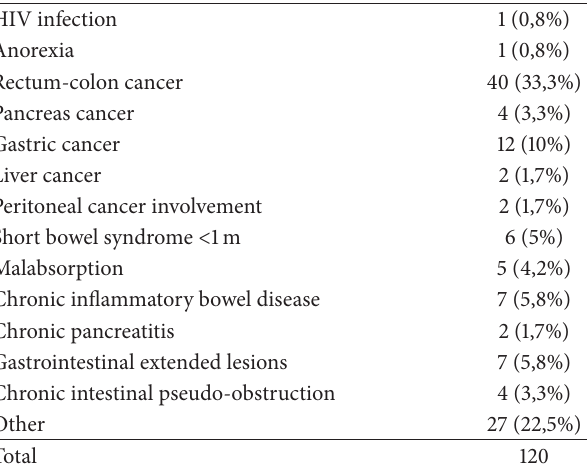
Figure 1: Relationship between software and doctors. Diagnosis: evaluation of malnutrition; strategy: strategy of nutritional support; product: nutritional mixture. Table 1: Patients included in the